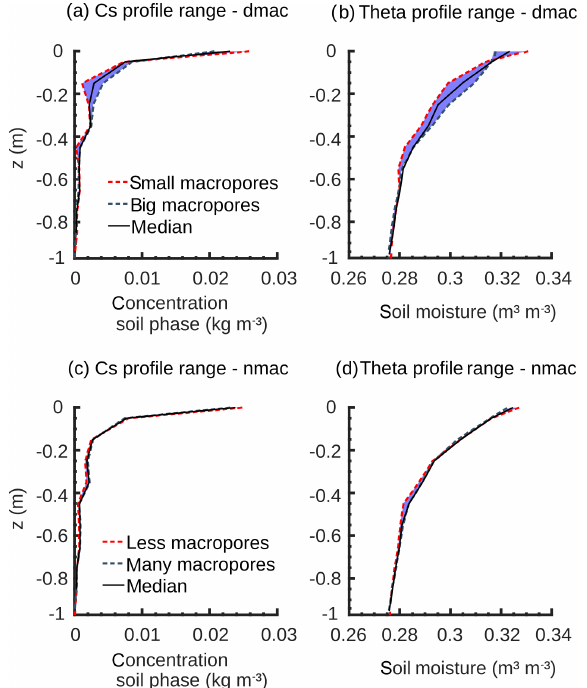
Figure 10. Final simulated bromide concentration (Cs) and soil moisture (theta) profiles of the soil matrix at three different macro- pore depth distribution configurations (a, b) and at four different distribution factor configurations (c, d) (cf. Table